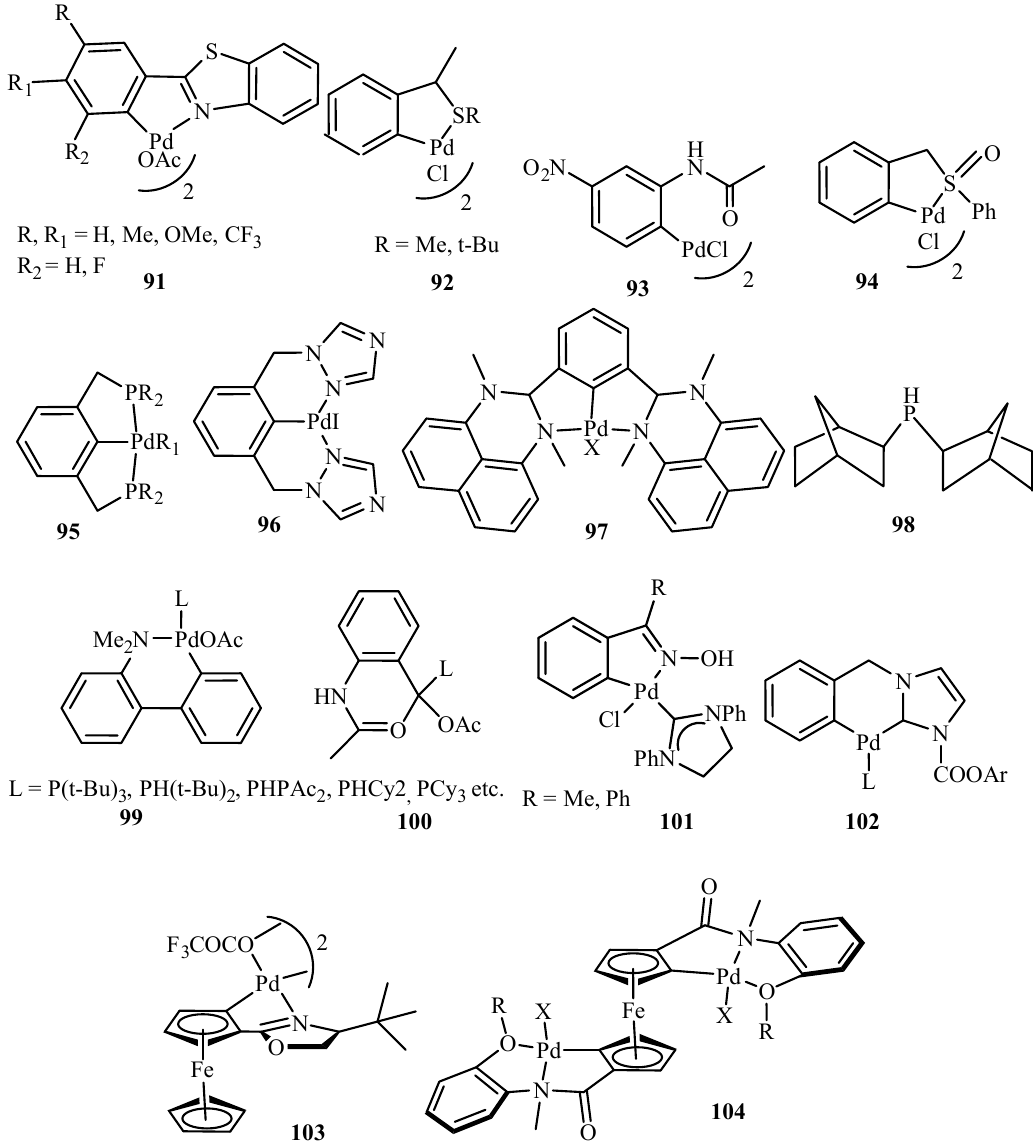
Figure 9. Ligands and palladacycles reviewed by Beletskaya and Cheprakov [20].